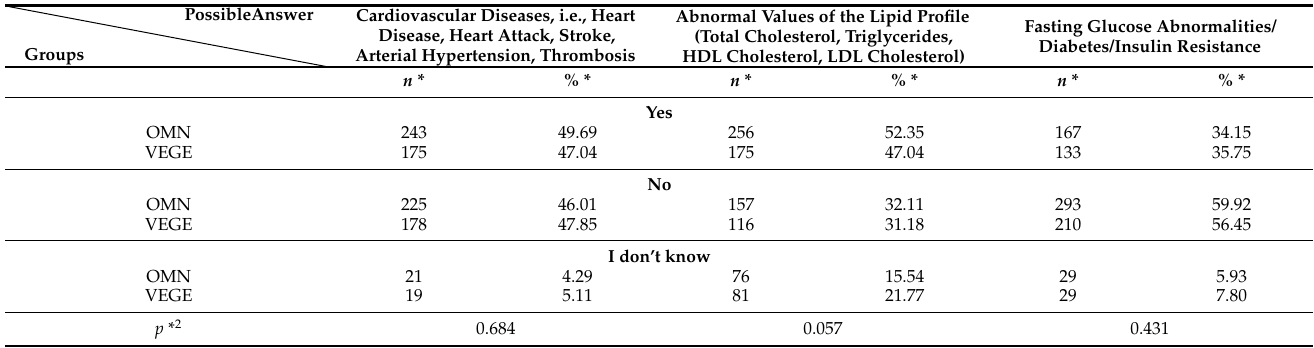
Table 2. Family history of cardiometabolic disease.